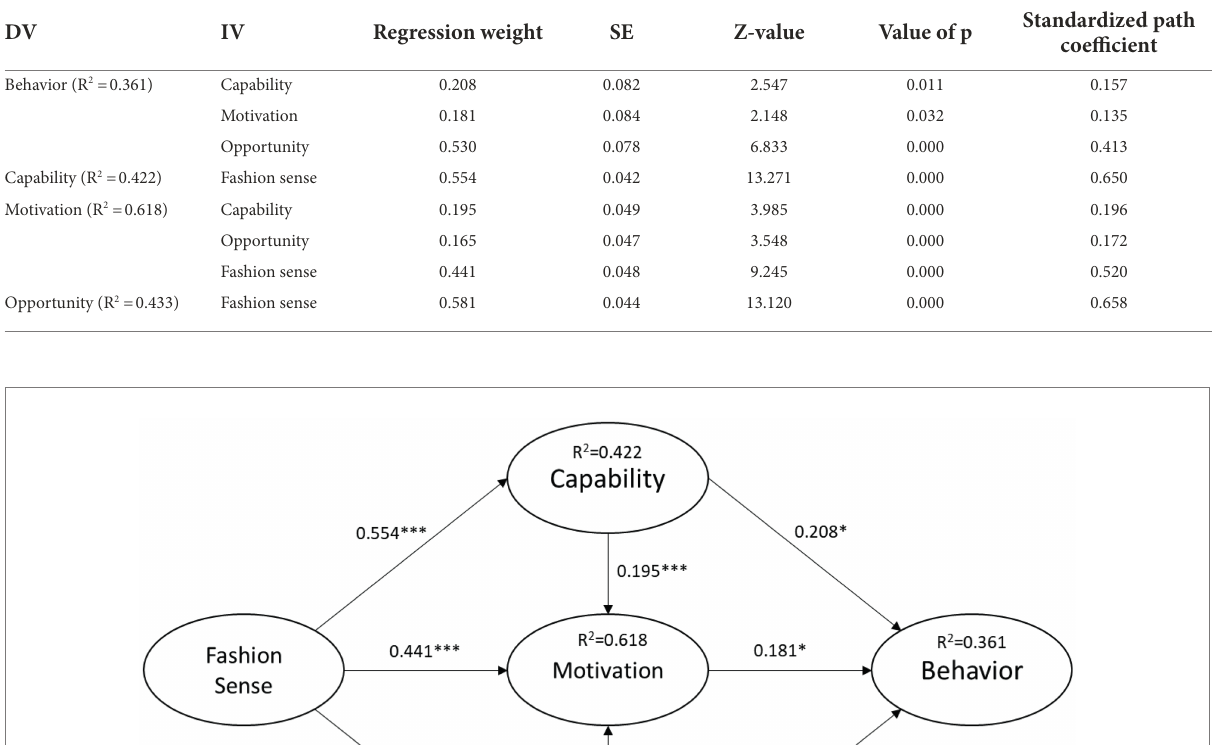
TABLE 6 Path analysis table.